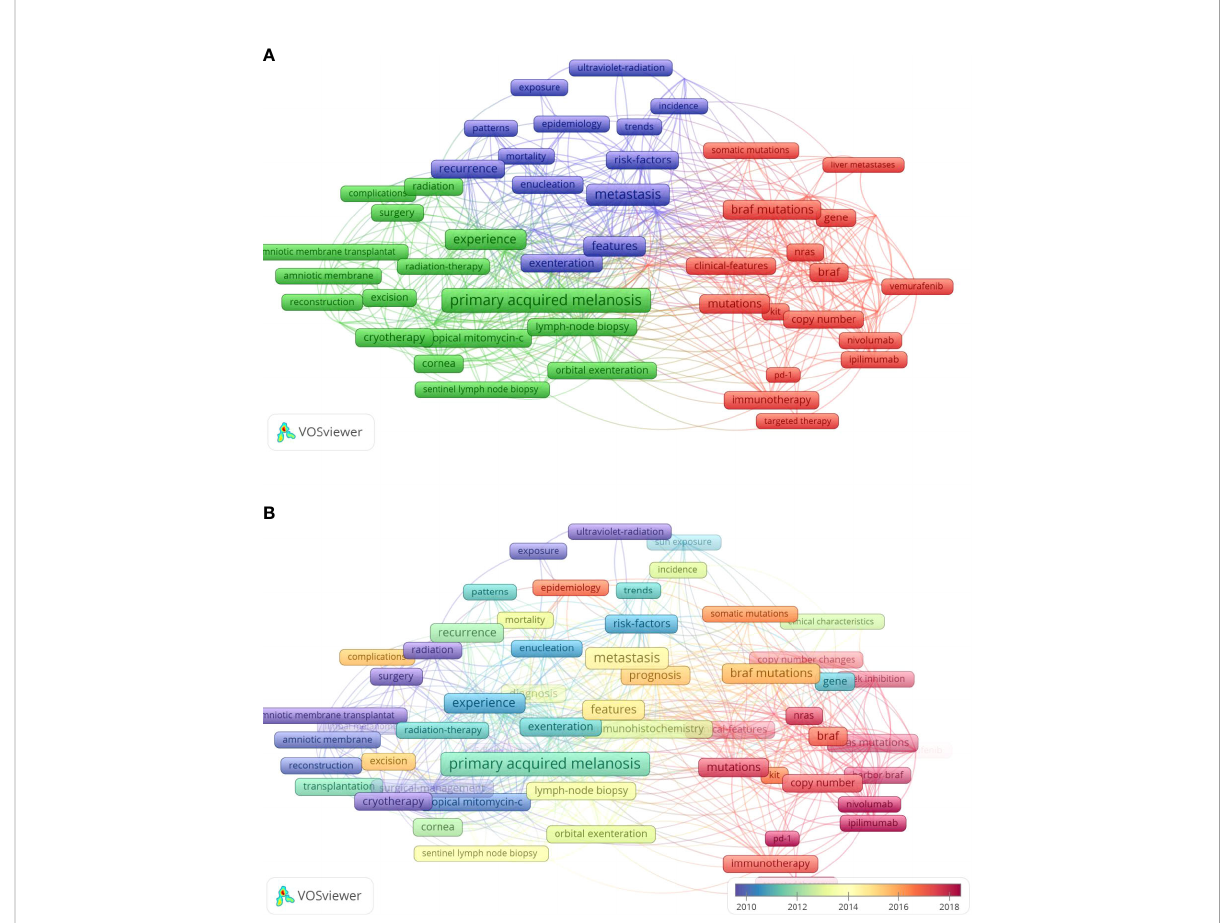
FIGURE 5 The analysis of keywords in CM researches. (A) Mapping of the keywords in CM researches. All keywords were divided into three clusters and given different colors: management-related research (left in green), genetic research (right in red), and clinical research (up in